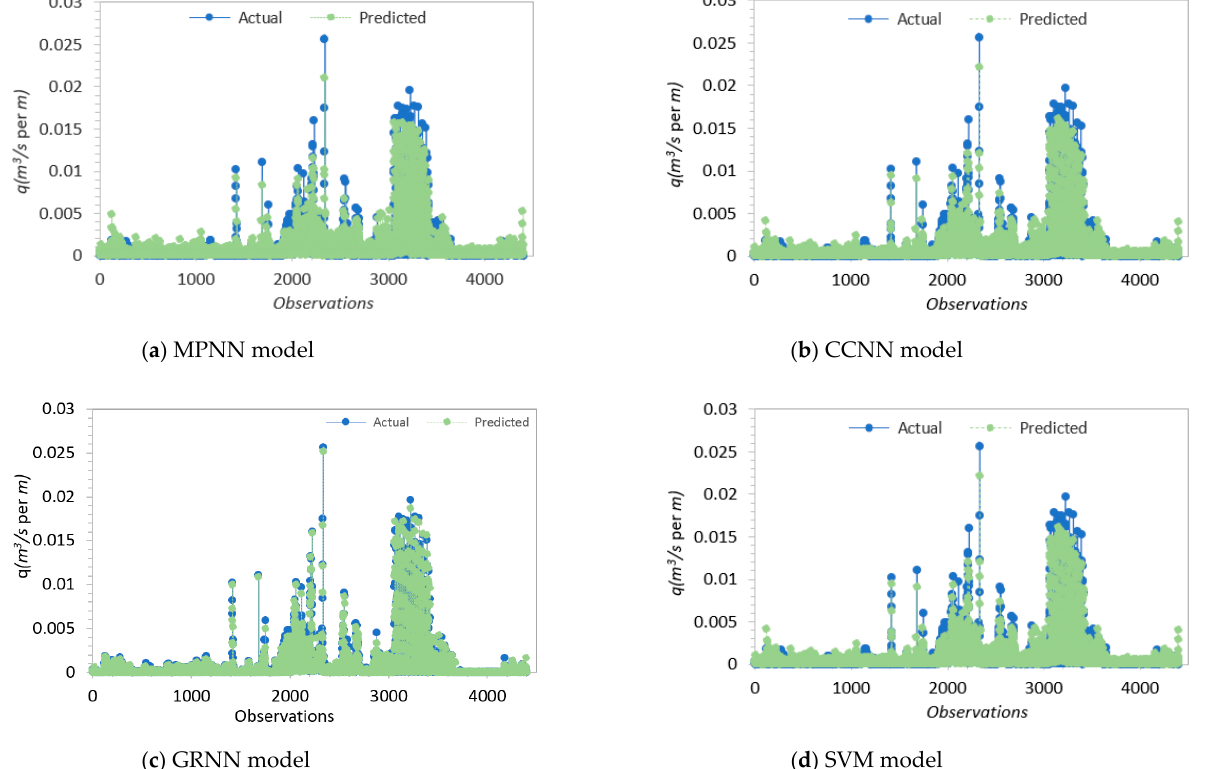
Figure 6. Plot of the measured and predicted values of wave-overtopping.